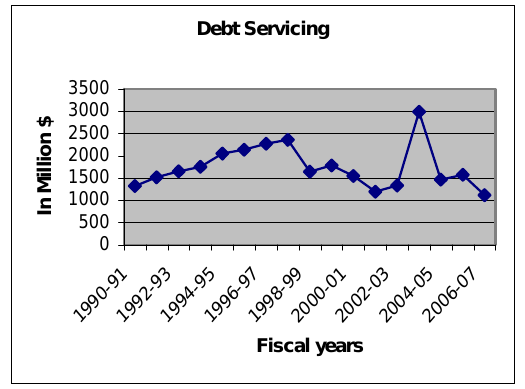
Graph 2 Source: Different economic surveys of